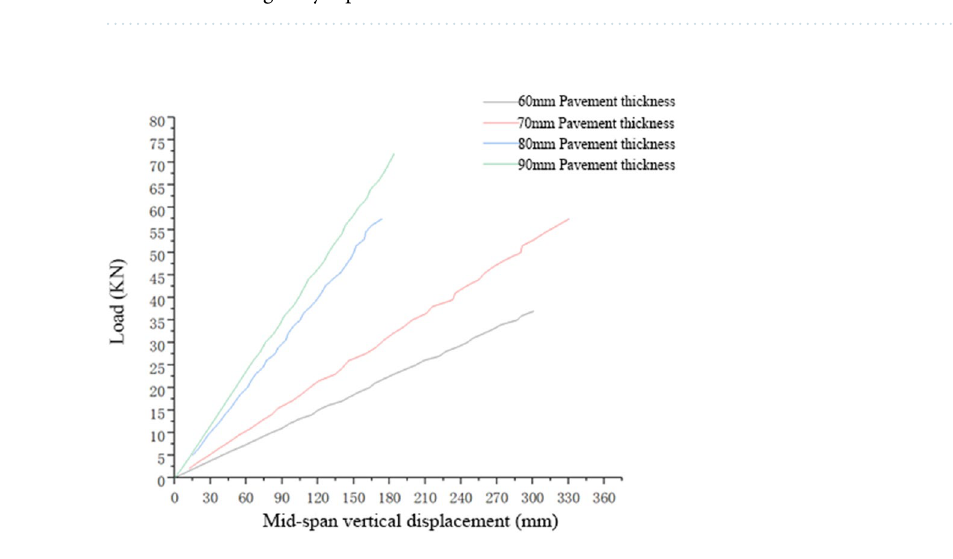
Table 3. Flexural and tensile stiffness and failure load of the composite structure formed by different thicknesses of single-layer pavement.